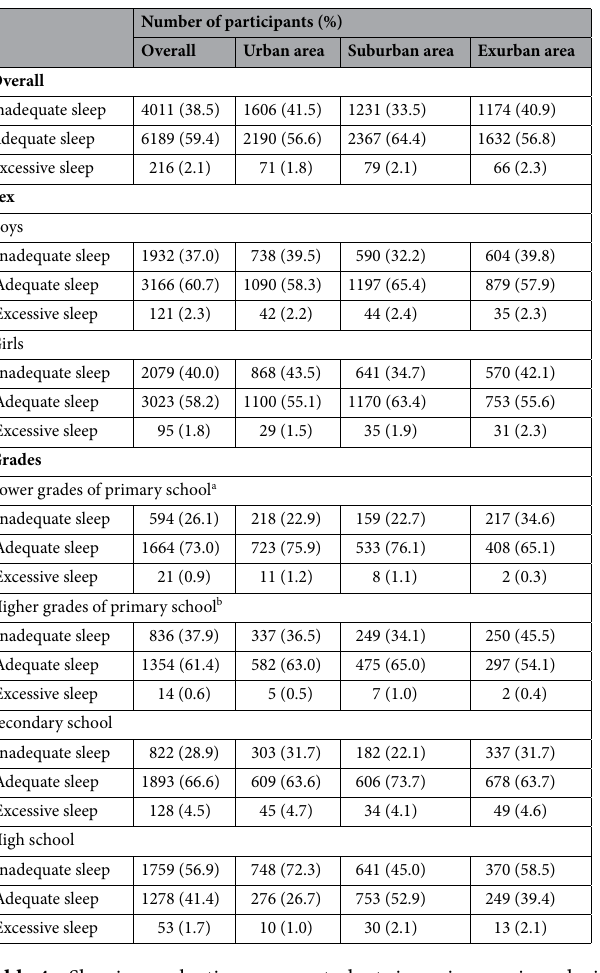
Table 4. Sleeping evaluation among students in various regions during the COVID-19 pandemic. All data are presented as frequency and its percentage. a Lower grades of primary school: grades 1st to 3rd in